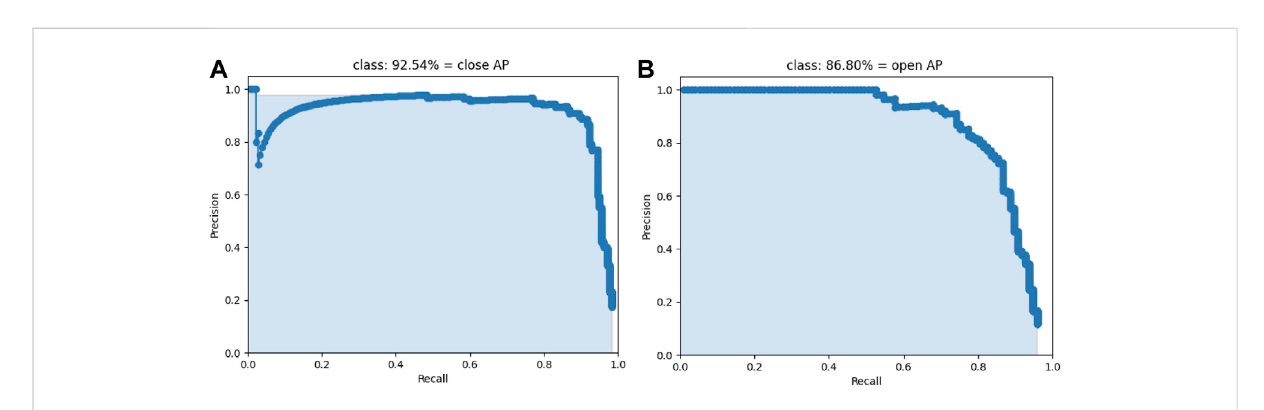
FIGURE 9 AP of improved YOLOv4 model. (A) close AP ; (B) open AP